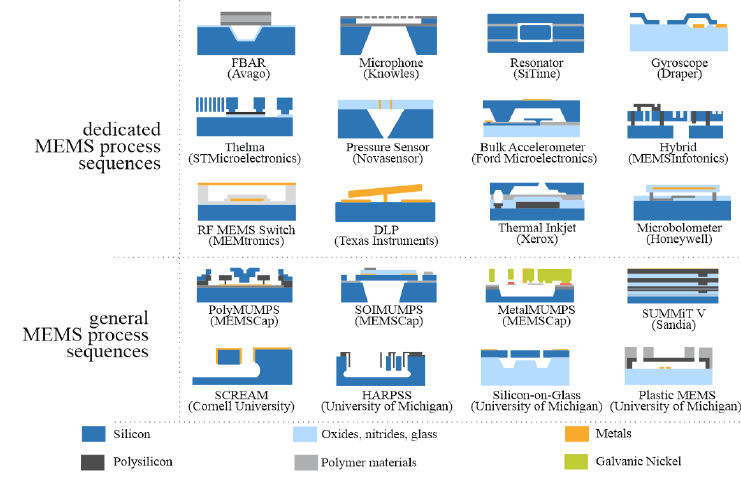
Fig. 10. An example of existing MEMS processes.